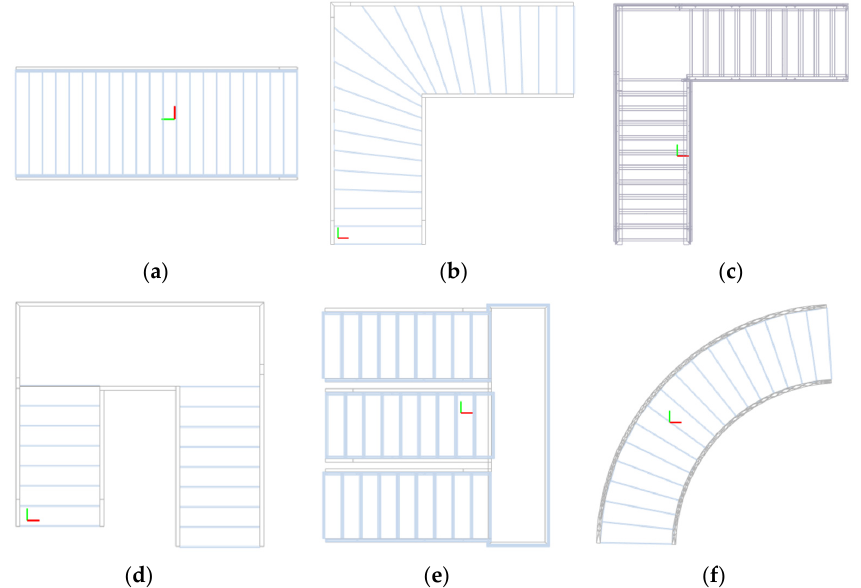
Figure 14. The X-Z projections of the evaluated stairs: ( a ) straight stair, ( b ) turn stair, ( c ) L-style stair, ( d ) n-style stair, ( e ) m-style stair, and ( f ) spiral